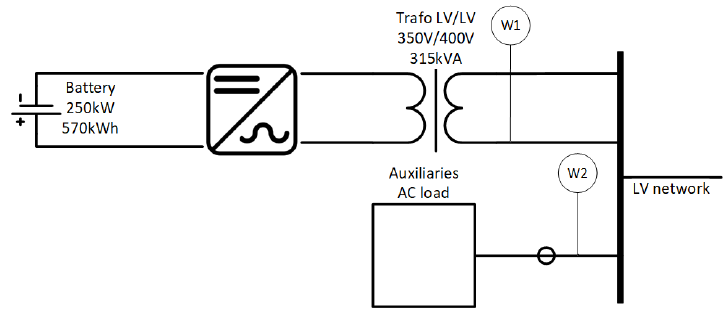
Figure 1. Battery energy storage systems (BESS) scheme with measurement boxes position.